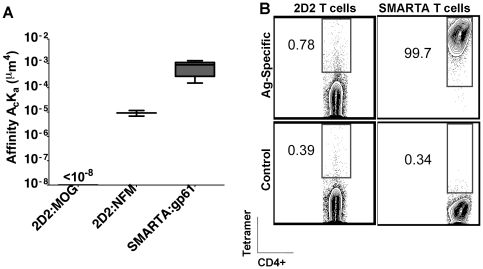
The effective 2D affinity of 2D2 and SMARTA CD4+ T cells differs.(A) 2D2 or SMARTA T cells were stained with antigen-specific I-Ab tetramer (MOG38–49 or gp66–77, respectively) or a negative control I-Ab tetramer and analyzed by flow cytometry, gated on CD4+ cells. (B) Human RBCs were coated with the indicated pMHC complex and brought into contact with the corresponding T cell by micropipette numerous times. The resulting adhesion frequency was used to derive the effective 2D affinity (AcKa, in µm4). All experiments were performed at least three times.